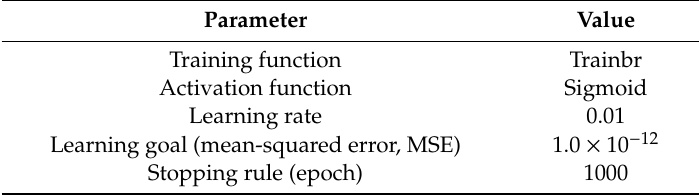
Figure 6. Performance of back propagation artificial neural network. ( a ) Test error in different quantity of hidden nodes, ( b ) training curve of the model with 26 nodes in the hidden layer. Table 3. Parameters of back-propagation artificial neural network.